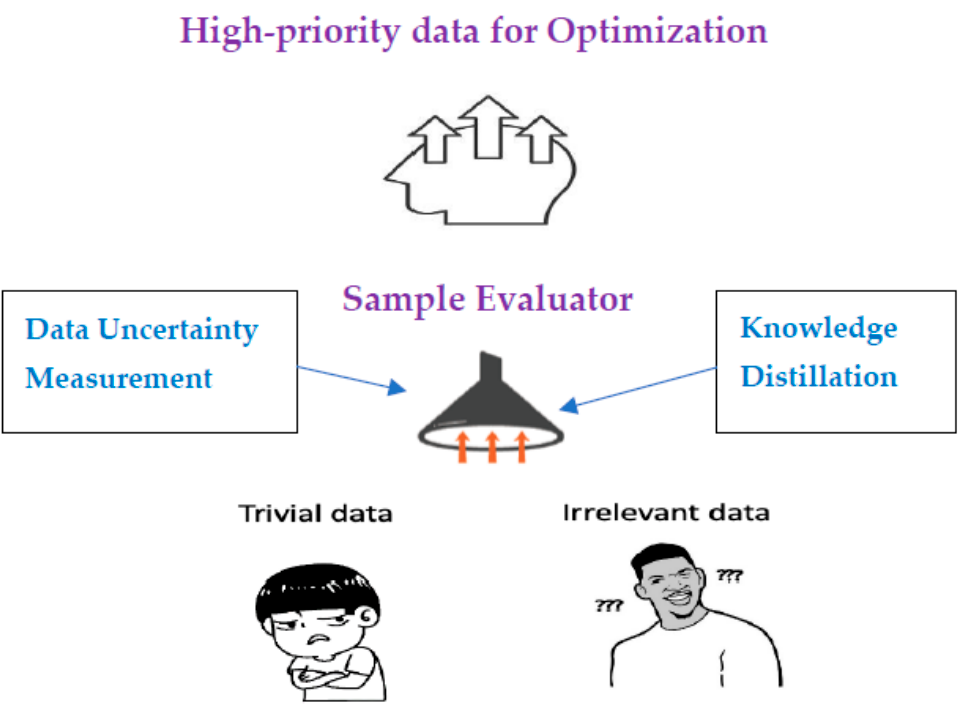
Figure 5. The effects of the sample evaluator (with the aid of knowledge distillation and measurement of data uncertainty).